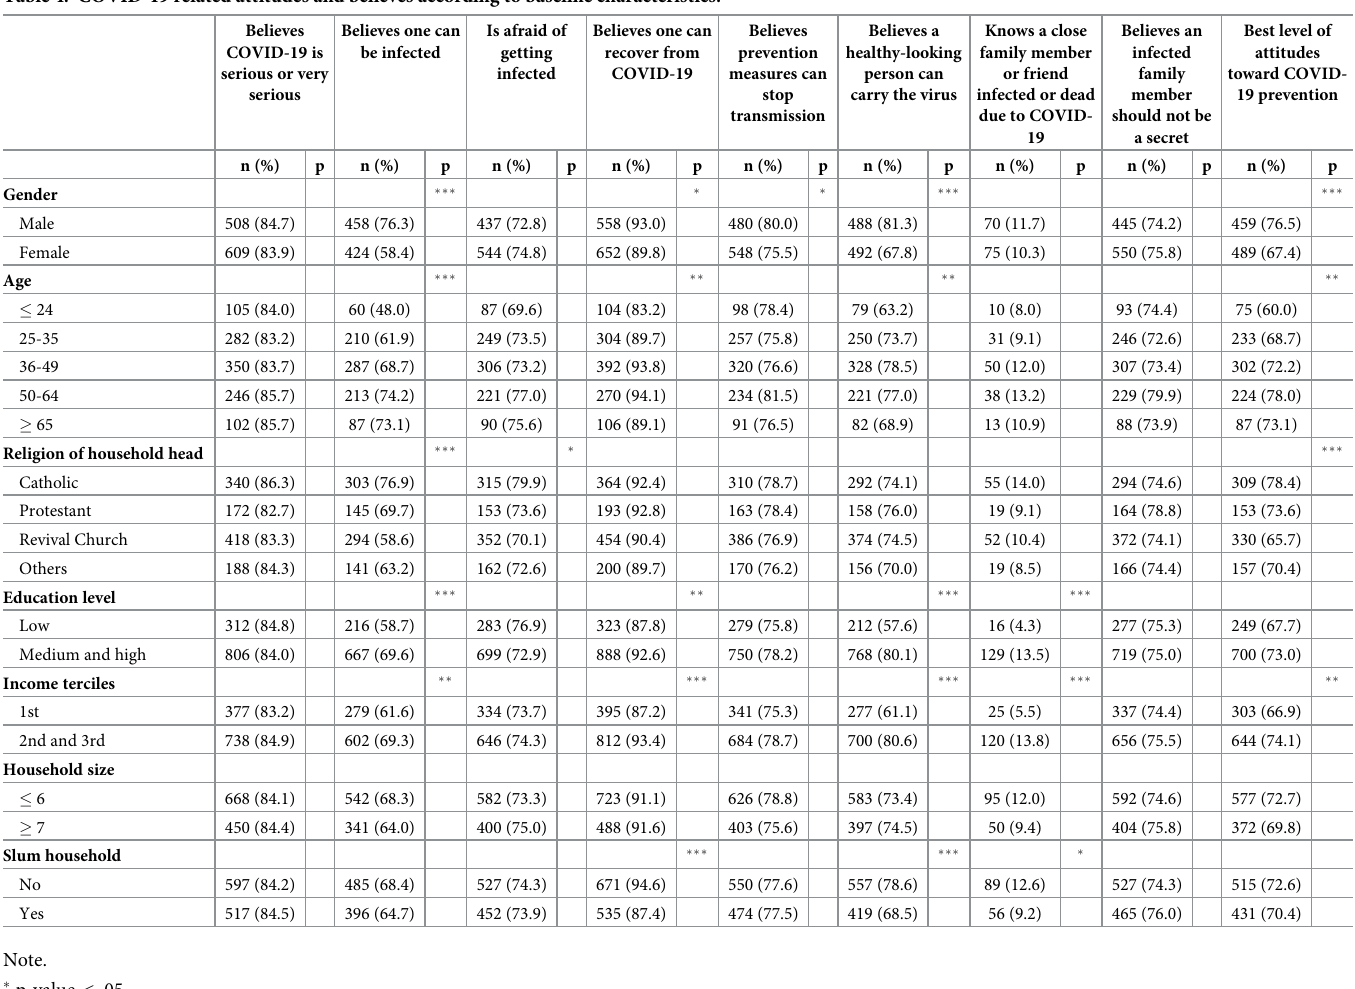
Table 4. COVID-19 related attitudes and believes according to baseline